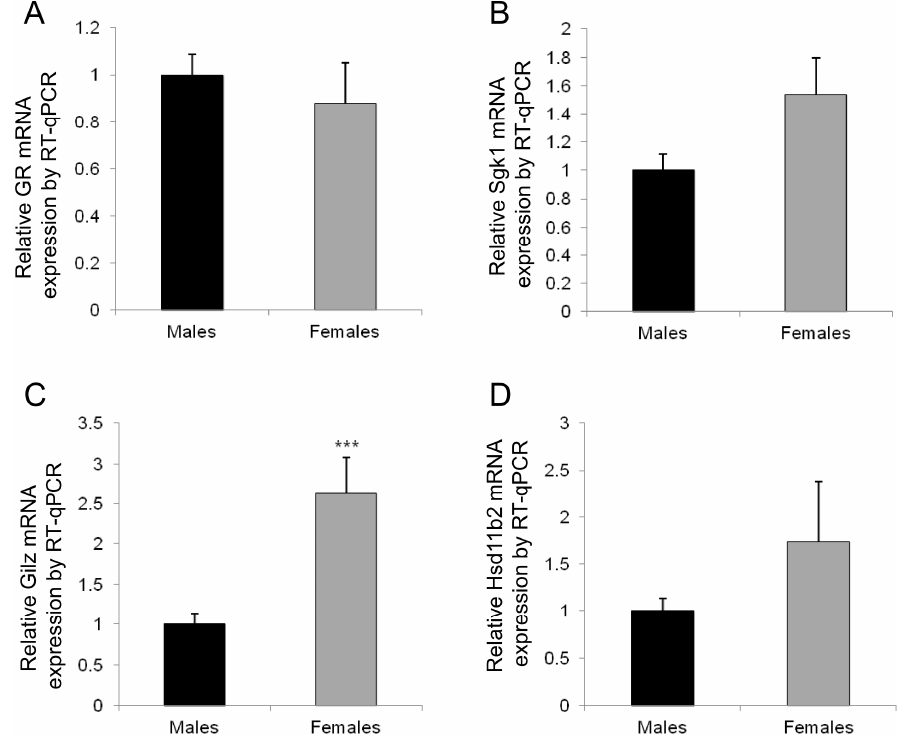
Figure 5. Tissue-specificity in sexual dimorphism in the expression of GRs, Hsd11b2 and several MR-regulated target genes: example in the lung of adult (M3) mice. GR ( A ); Sgk1 ( B ); Gilz ( C ); and Hsd11b2 ( D ) pulmonary relative mRNA expressions in adult mice (M3: 3-month-old) were determined using RT-qPCR. Results, expressed as the ratio of attomoles of specific gene per femtomole of ribosomal 18S, normalized to the expression of male mice arbitrarily set at 1, correspond to mean ± SEM of three independent experiments comprising at least 6 male and 6 female lungs each. *** p < 0.001.